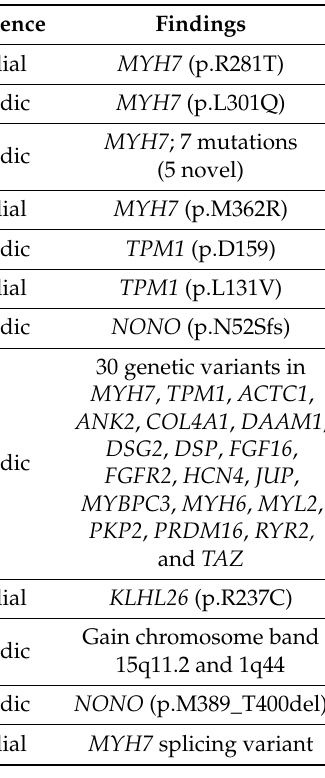
Table 4. Summary of published work describing combined EA/LVNC-associated